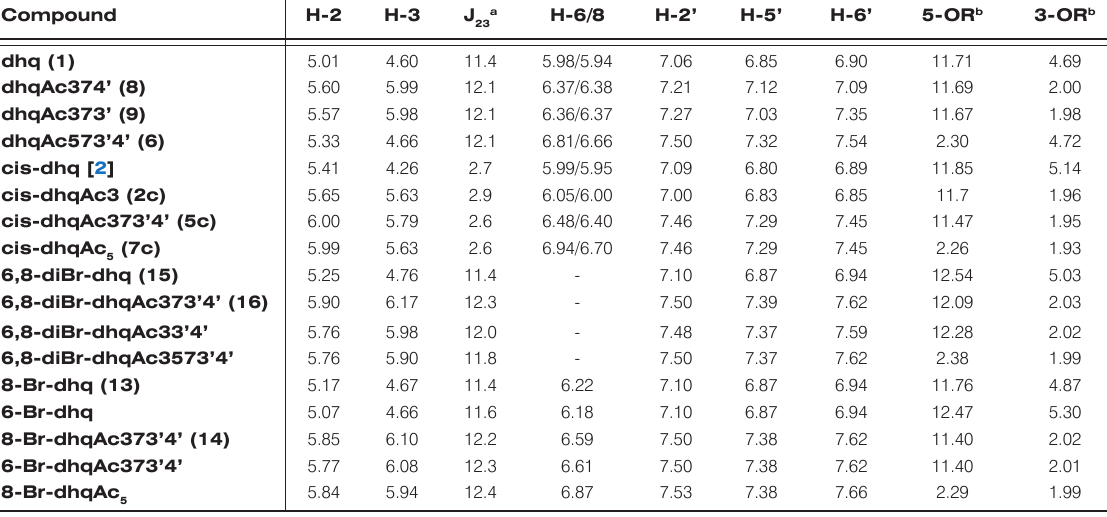
Table 1. Proton Chemical Shifts (ppm) of Dihydroquercetin Derivatives